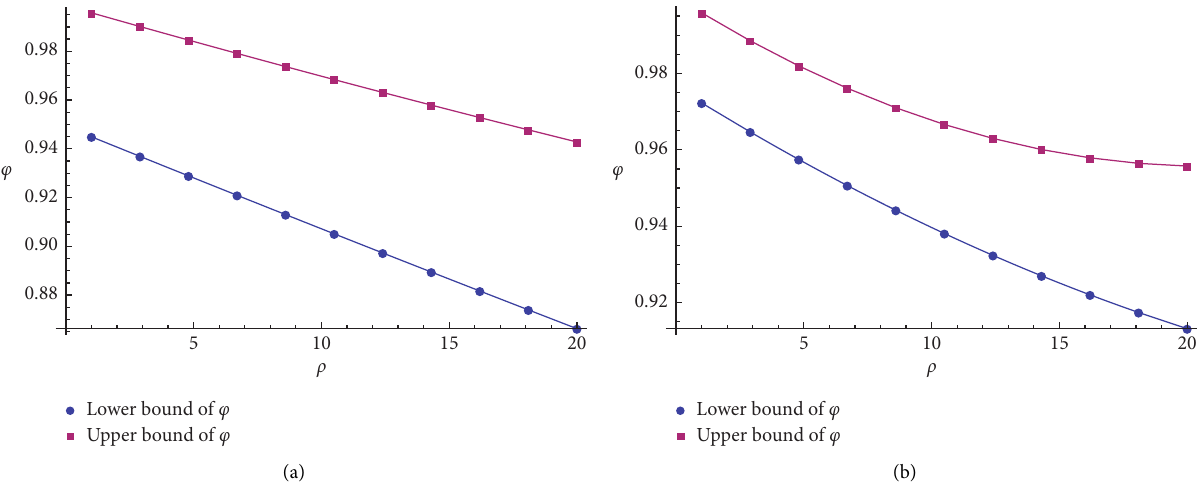
Figure 2: Change in bounds of ϕ with ρ : (a) the case without fairness concerns; (b) the case with fairness